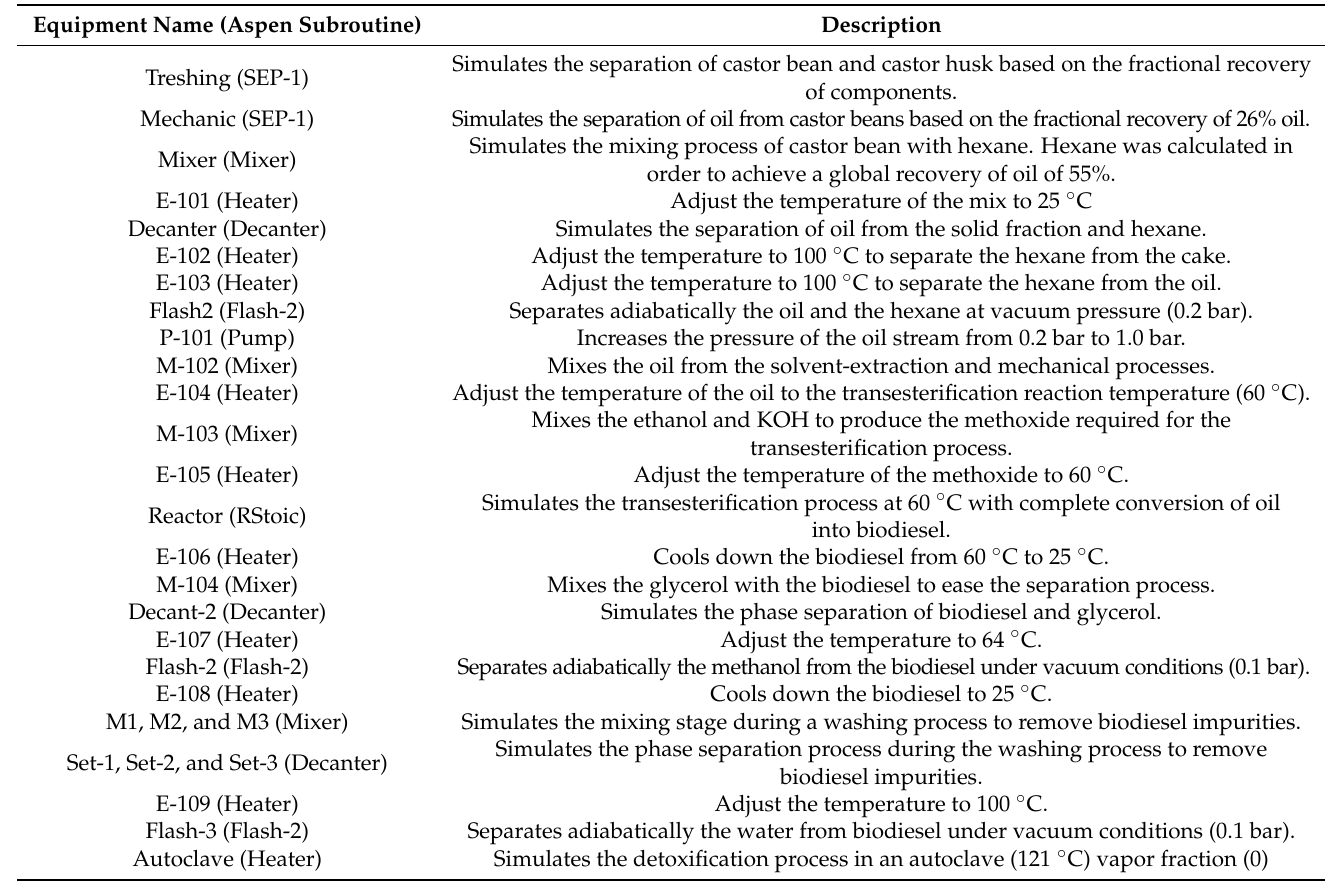
Table 2. Aspen plus subroutines